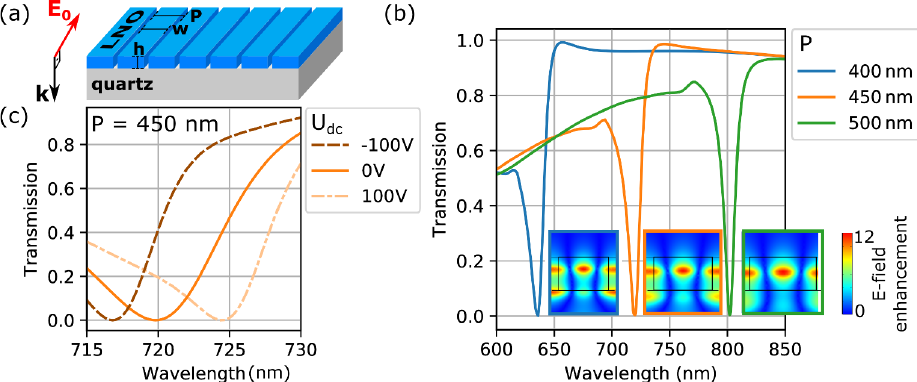
Figure 1. (a) Schematic of LNO gratings on a quartz substrate: period P , width w = P − 100 nm, height h = 200 nm. (b) Calculated transmittance of a plane wave polarized along the gratings at normal incidence. The insets show the electric field enhancement at the transmission resonance in a plane perpendicular to the grating. (c) Calculated transmission under actuation with a DC-bias voltage for the LNO grating with a period of 450